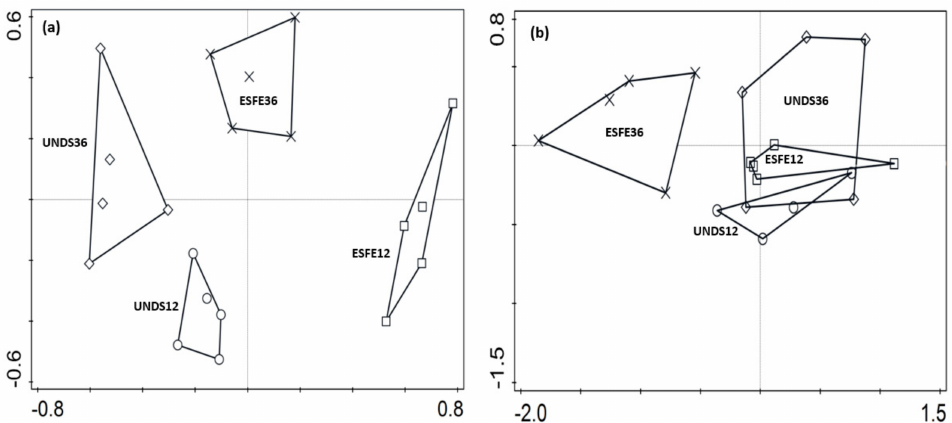
Figure 3. Ordination of soil samples on the biplot resulting from the PCA based on the nematode species composition ( a ) and microbial characteristics ( b ) of the soil samples in disturbed (ESFE12—square, ESFE36—crosslet) and undisturbed plots (UNDS12—circles, UNDS36—rhomb), 12 and 36 months after